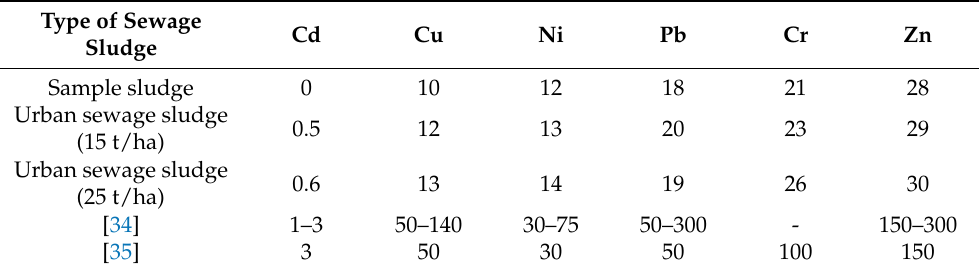
Table 6. The variation of the content of heavy metals (total forms) in the soil fertilized with urban sewage sludge from the wastewater treatment process in the Municipality of Alexandria, Teleorman [34,35].